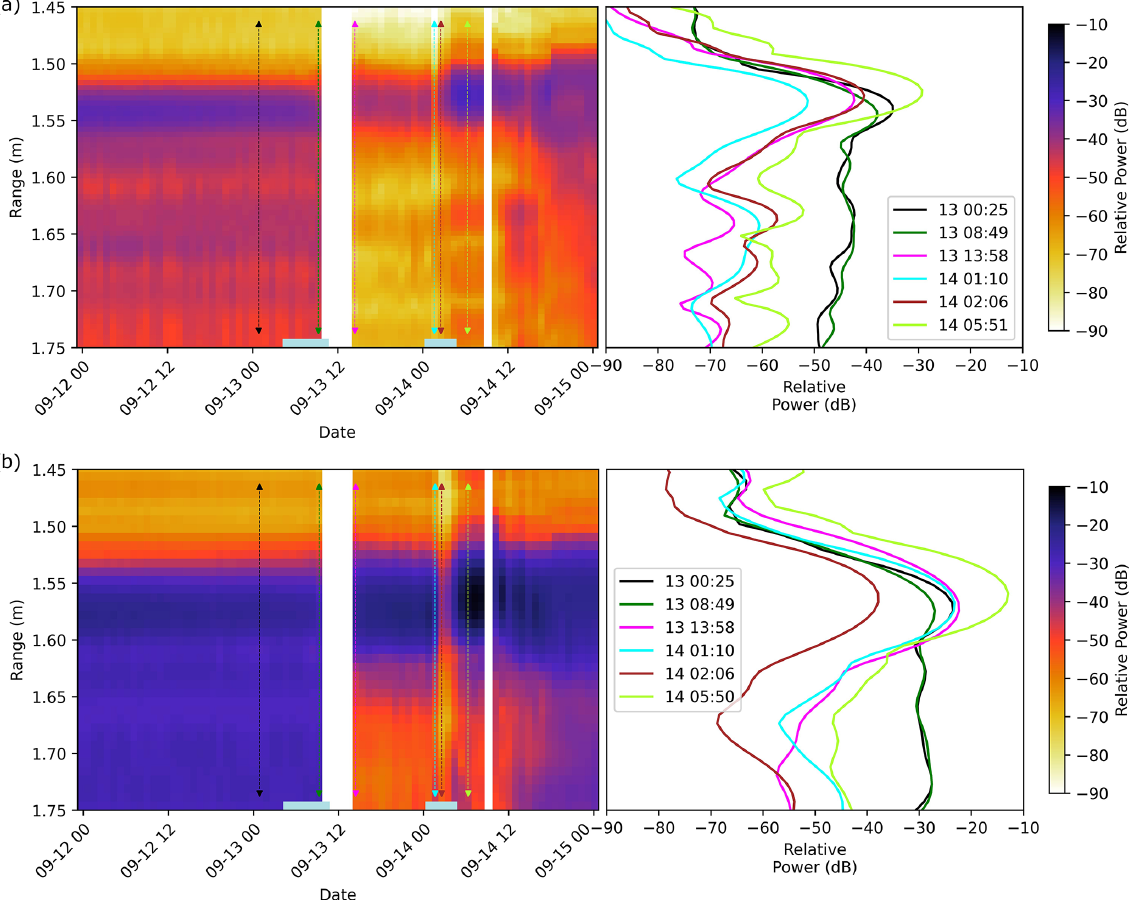
Figure 6. (a) Ka- and (b) Ku-band HH echograms at nadir, indicating scattering from different ranges, hence waveform shape over time. Vertical white stripes indicate data gaps. Light-blue boxes at the base indicate the rainfall periods. Inset panels on the right indicate waveforms selected at the dates and times shown by the arrows in the echograms, demonstrating changes in waveform shape, and leading edges during the 24h